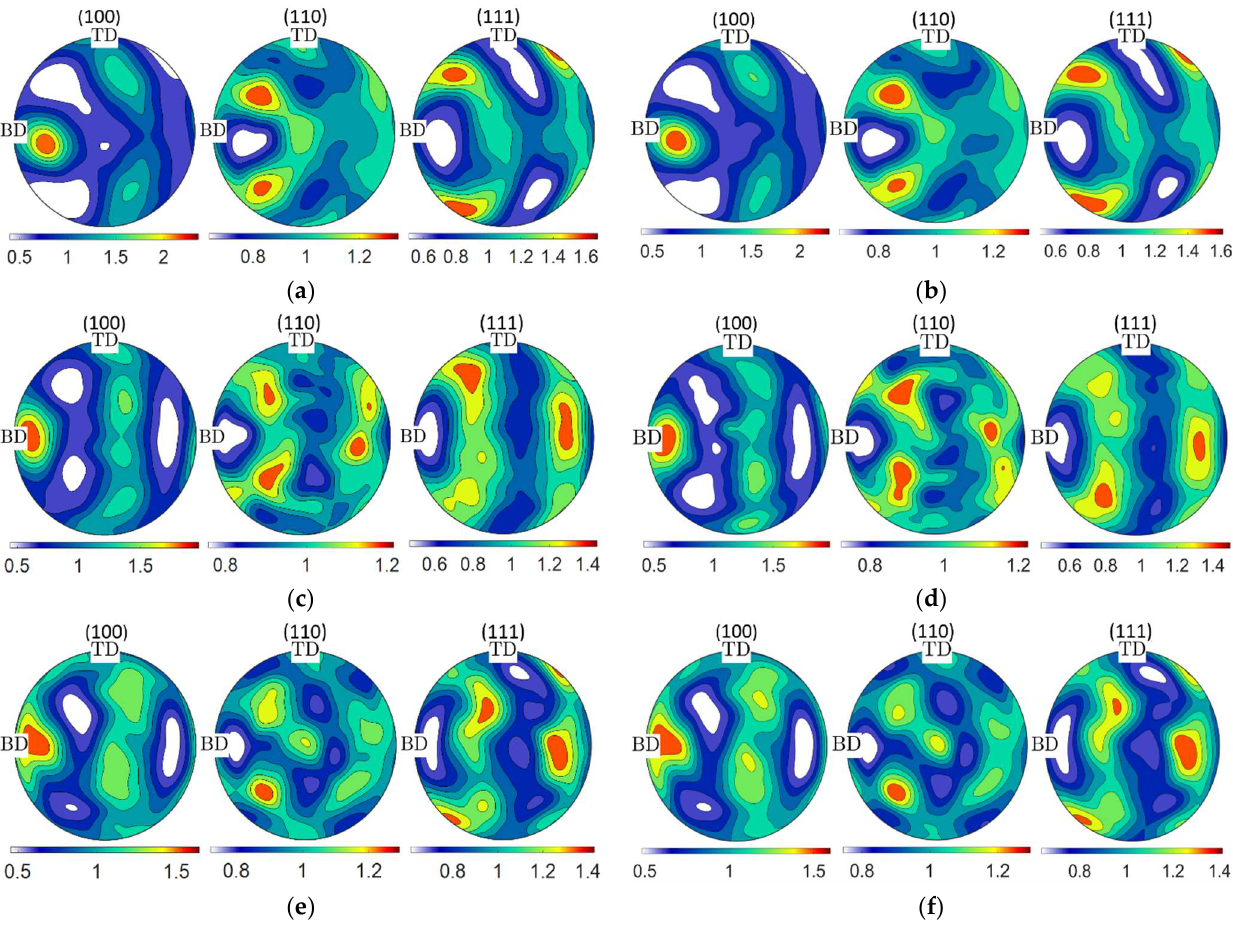
Figure 6. Pole figures for the ODFs estimated from the EBSD data, ( a ) AB state, ( c ) HT1 state, ( e ) HT2 state, and ( b , d , f ) reconstructed ODFs from the orientations of the AB and HT states, respectively. In addition to the crystallographic texture, polycrystalline materials also are character- ized by a specific grain boundary texture, which can be described by the grain boundary misorientation angle distribution. To replicate the distribution experimentally determined